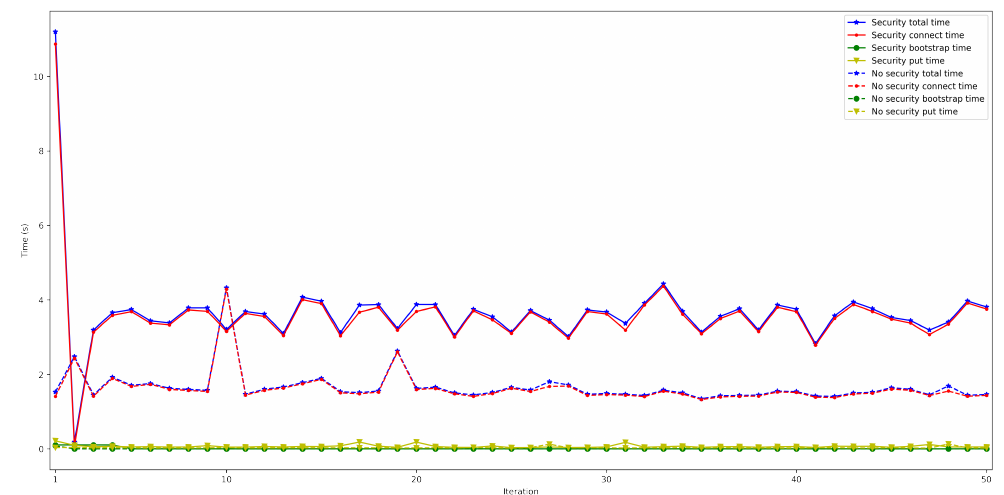
Figure 25. Latency when enabling/disabling TLS 1.3 for 300 peers connected to the bootstrap node.